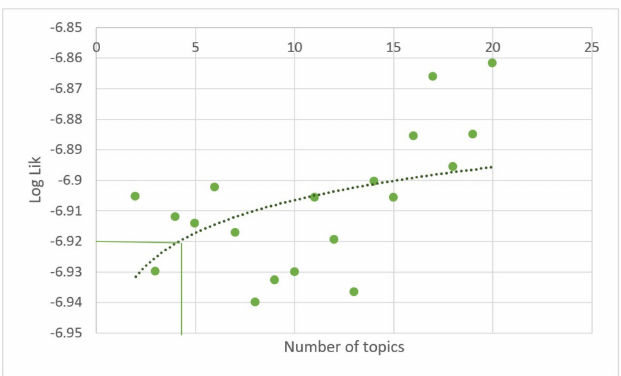
Figure 2. Predictive likelihood of models with different number of topics.